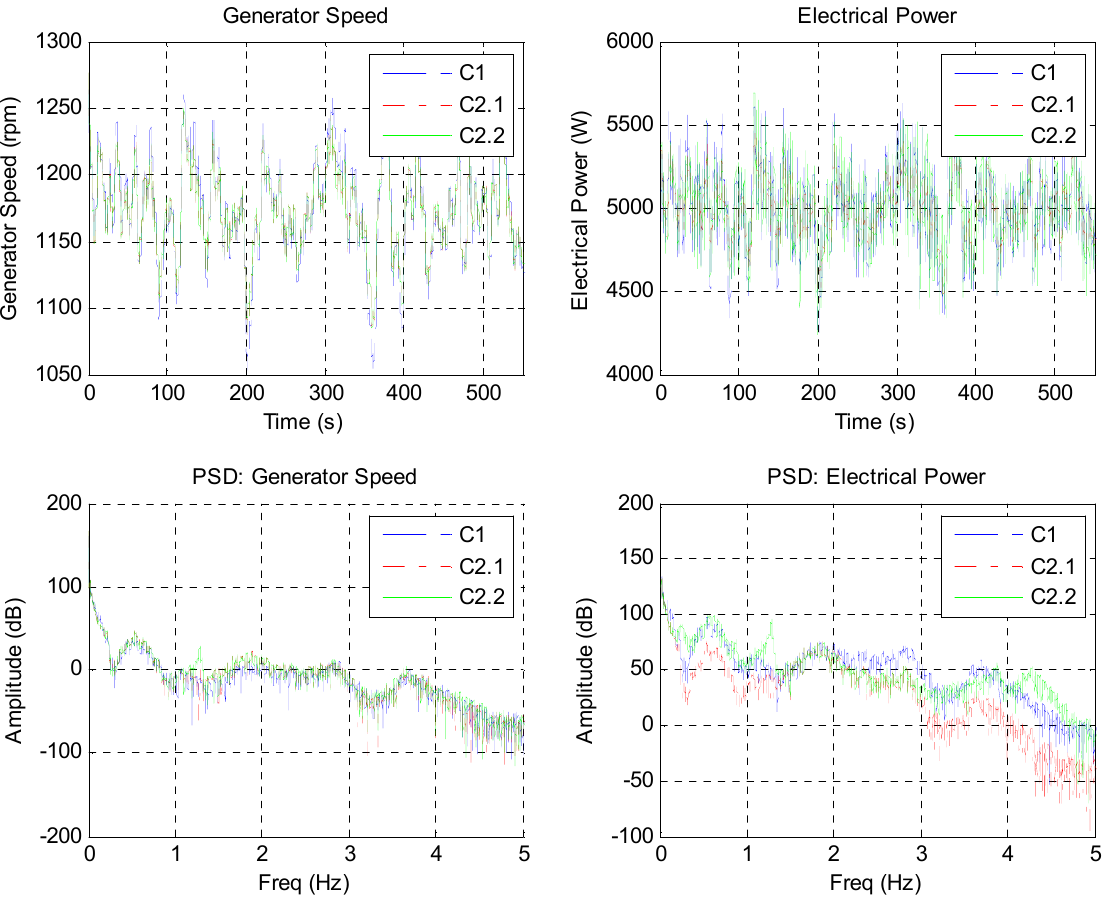
Figure 17. Generator speed and electrical power with a turbulent production wind of 19